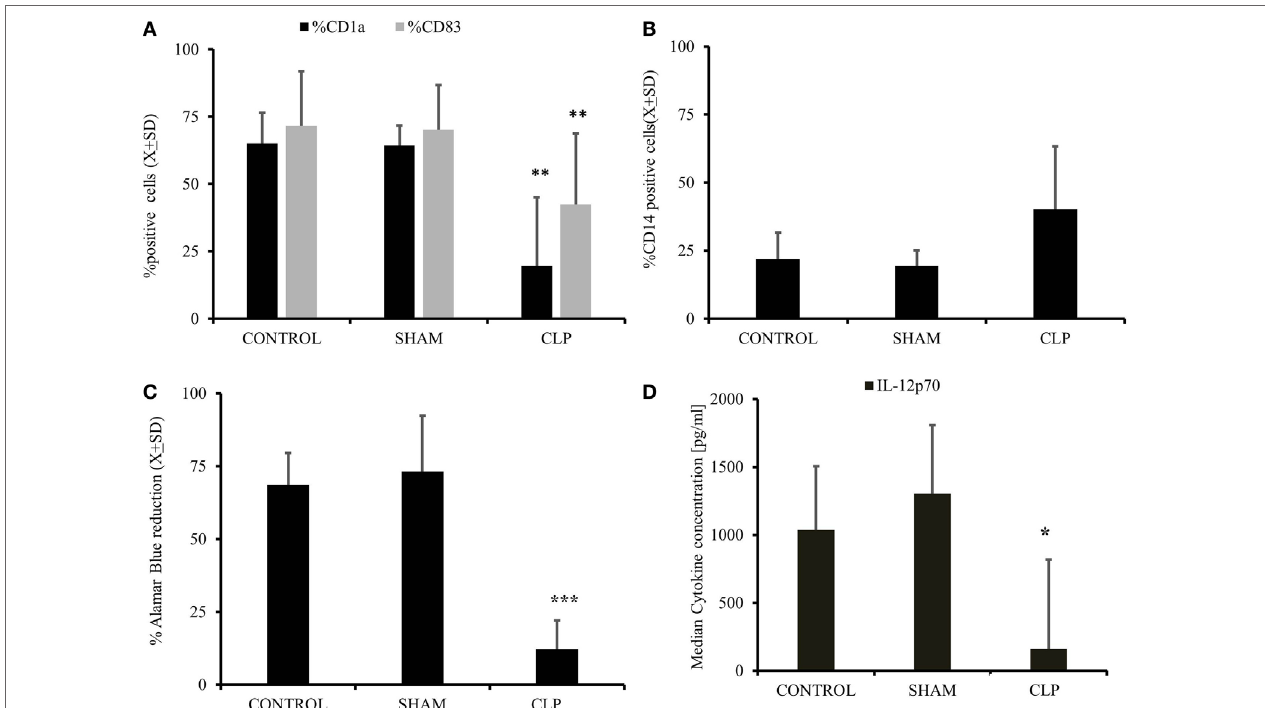
FigUre 1 | cecal ligation and puncture (clP) results in long-term diminished ability of myeloid cells to become iDc in vitro after initial sepsis . Isolated monocytes (MO) obtained from untouched (CONTR; n = 8), sham-operated (SHAM; n = 6), and surviving 28 days after CLP (CLP; n = 14) were stimulated with IL-4&GM-CSF in vitro for 5 days followed by harvest to assess the degree of MO to iDC differentiation. Flow cytometry was used to assess the emergence of dendritic cell (DC)-specific markers like CD1a and CD83 (a) . CD14, a marker for undifferentiated monocyte, and not present typical on the surface of DC was assessed as well (B) . This flow cytometric evidence of the effectiveness of MO to iDC differentiation process was accompanied measure of the IL-4&GM-CSF- stimulated MO cells to stimulate allogeneic T cells in mixed lymphocyte reaction. IL-4&GM-CSF differentiation MO from each studied group were incubated 1:100 ratio with the presence of Alamar Blue, reduction of which represents the level of stimulation and antigen-presenting cell proficiency (c) . We also incubated with IL-4&GM-CSF differentiation MO lipopolysaccharide to assess the supernatants level of IL-12p70, a critical cytokine for T cells stimulation (D) . Bars represent average of results ( X ) with SD. Data were analyzed by one-way ANOVA for multiple group comparisons with a Bonferroni test for post hoc analysis (* p < 0.05, ** p < 0.01, *** p <